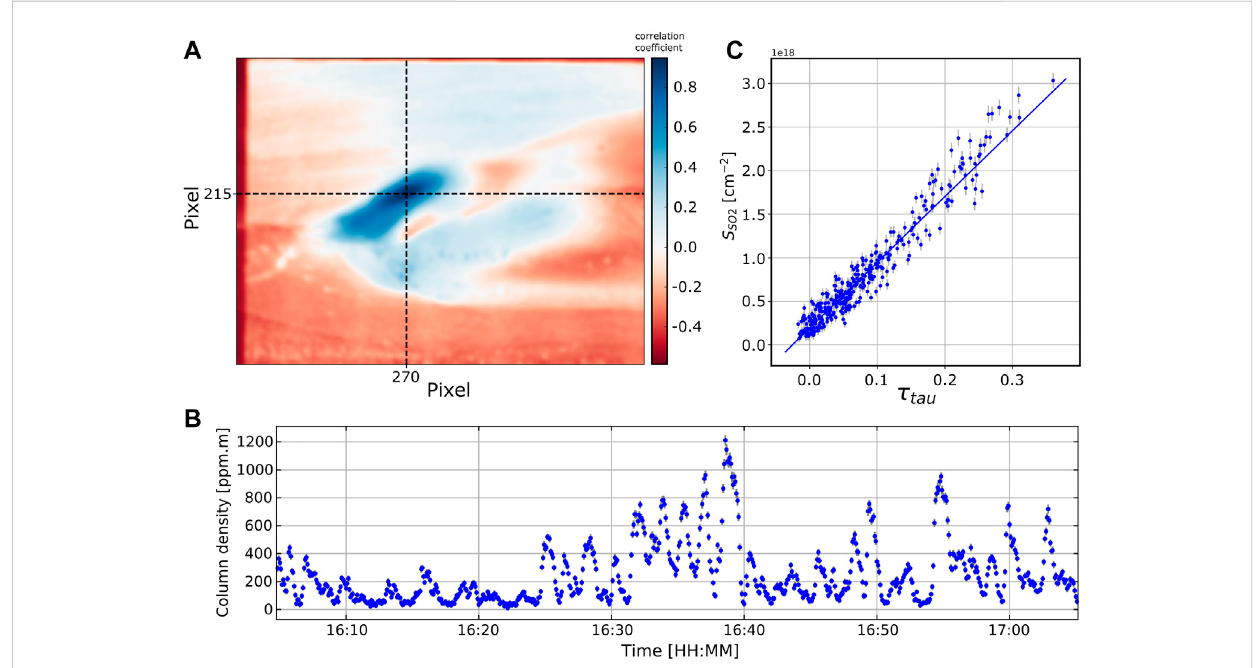
FIGURE 4 (A) Pearsoncorrelationcoef fi cients(colourscale)ofspectrometerSO 2 retrievalswithcameraopticaldepths( τ SO2 ),enablingdeterminationofwhere the spectrometer fi eld of view (FOV) is located within the camera image. In this case, the highest correlation coef fi cient is centered at pixel coordinate (270, 215). (B) Spectrometer-retrieved SO 2 slant column density retrieval time series (in UTC), highlighting that the FOV location is well-positioned to measure awide range ofcolumn densities throughtime,thereforeallowingarobust calibration ofthecameraopticaldepths. (C) Spectrometer SO 2 slant column density ( S SO2 ) retrievals versus camera optical depths measured in the spectrometer ’ s FOV (as determined in A). The fi tted calibration line is used to calibrate all pixel optical depths in the